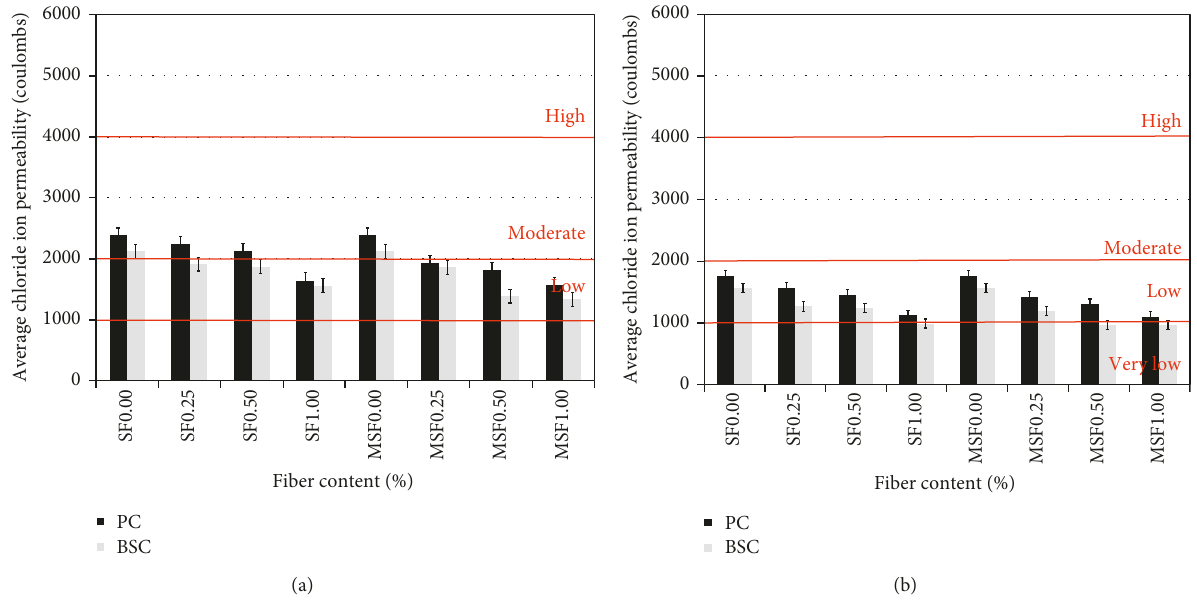
Figure 13: Chloride ion penetration test results of concrete segments with fiber volume fraction. (a) 40 MPa. (b) 60MPa.